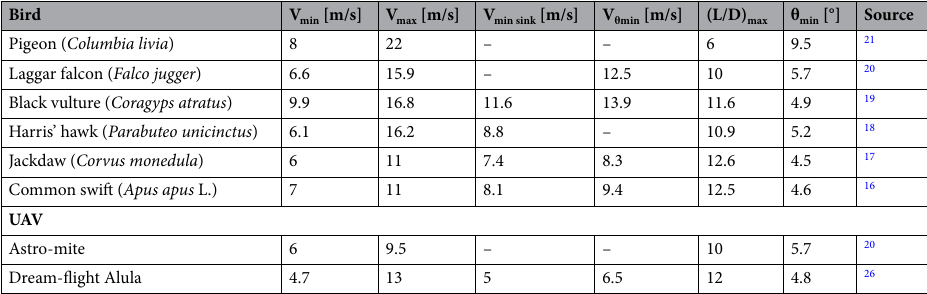
Table 1. Velocities and glide angles reported from wind tunnel tests with soaring birds and